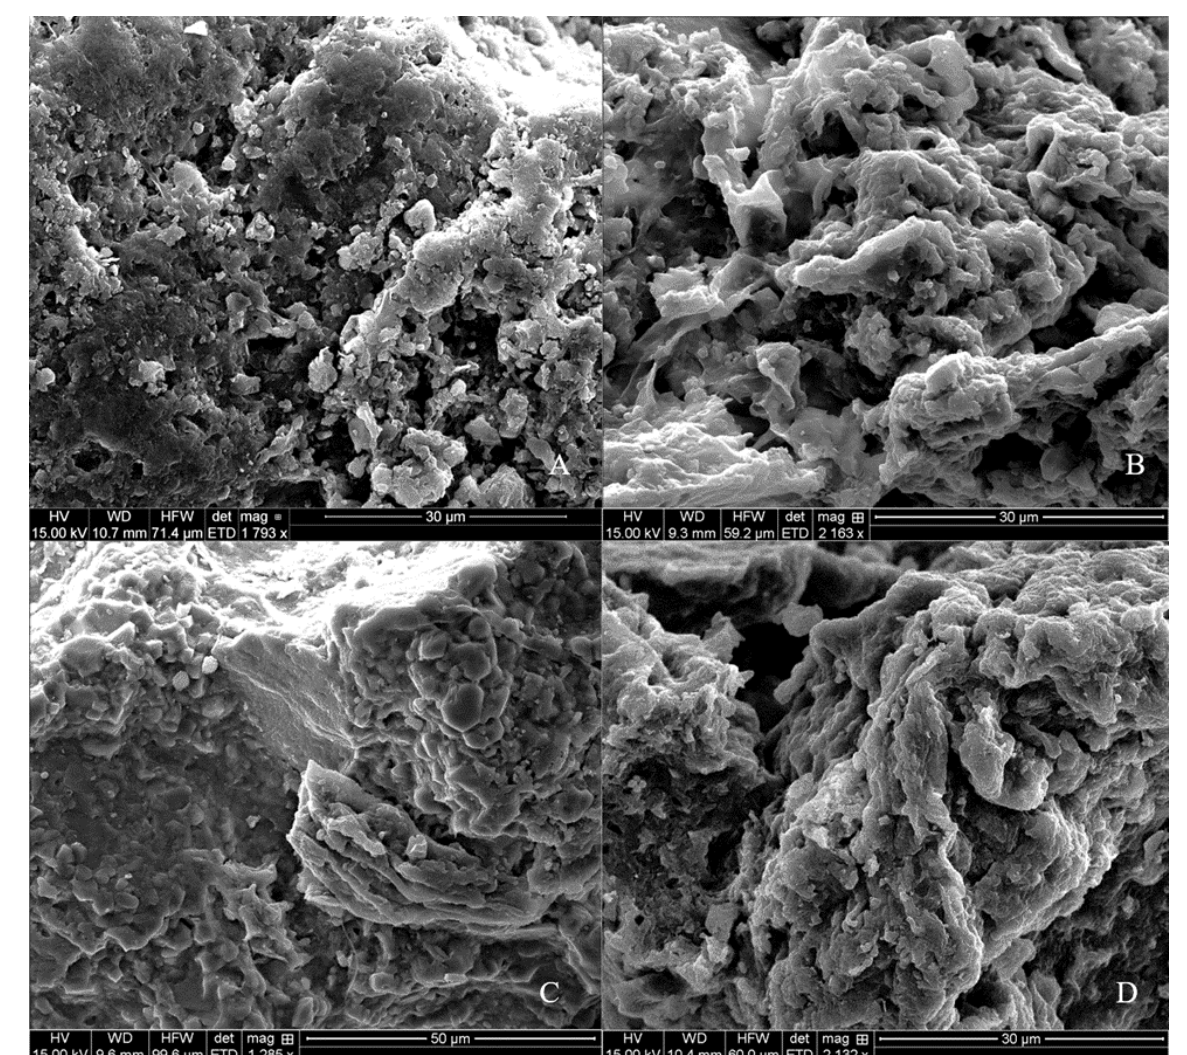
Figure 5. Representative scanning electronic microscopy (SEM) images of hydrophobic sand particles that received three sequential applications of wetting agent treatments and following washes. Treatments included an alkyl block polymer (ABP); ( A ), a polyoxyalkylene polymer (PoAP); ( B ), along with water ( C ) and an untreated control ( D ).